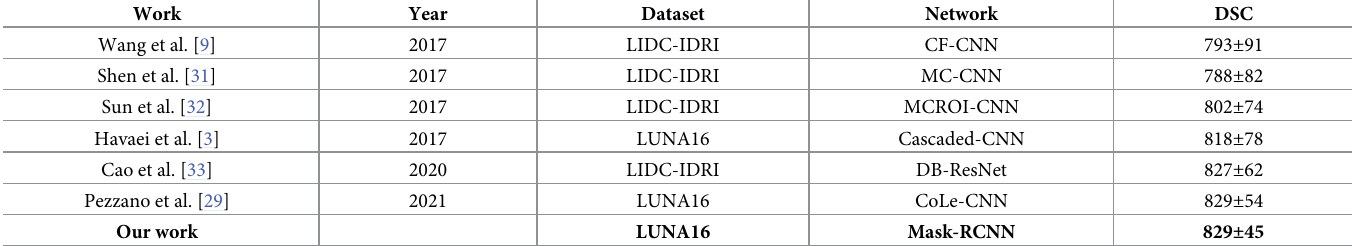
Table 6. Comparison of our work to pulmonary nodule segmentation state-of-the-art methods. All results are multiplied by 1000 and the bold font highlights the best results. Work